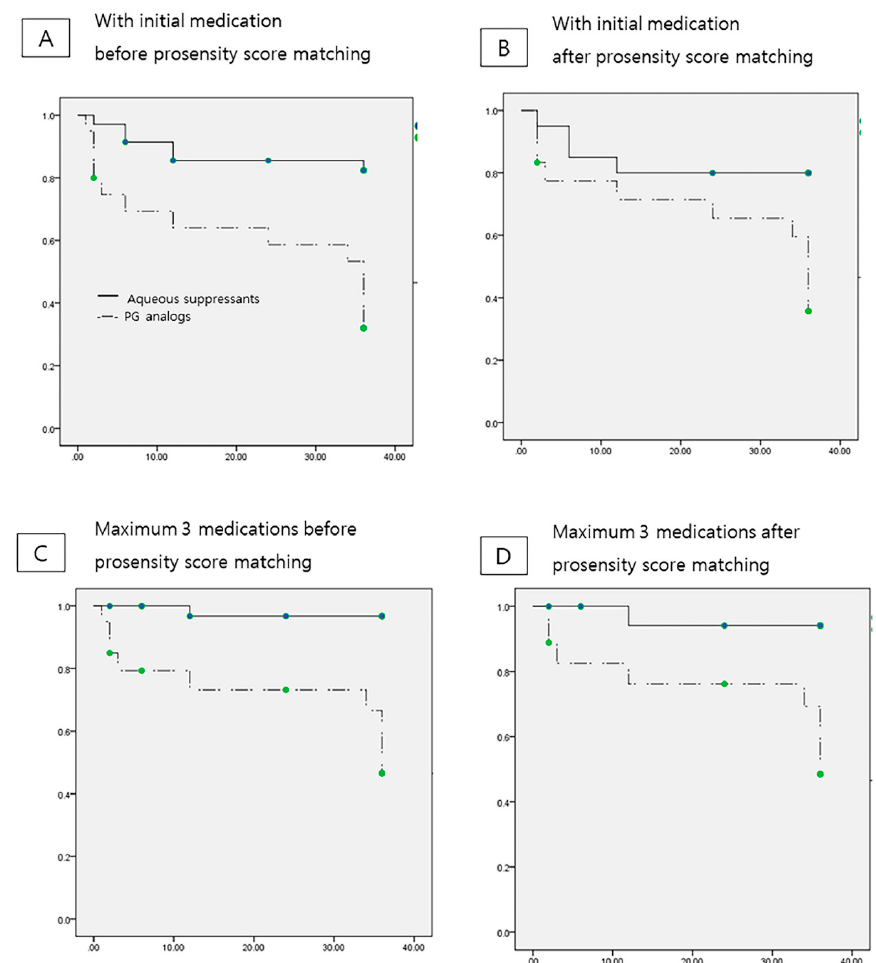
Figure 3. Kaplan–Meier analysis of the cumulative probability of qualified success over time considering initial glaucoma medication in the hypertensive phase after AGV implantation before and after propensity score matching regardless of number of medications used, the cumulative probability of qualified success was higher in the aqueous suppressants group than in the prostaglandin analogs group. With one initial medication, before propensity score matching analysis ( A ), the analysis revealed 82.9% for aqueous suppressants group, 35% for prostaglandin analog group ( p < 0.001), and after propensity score analysis ( B ), 80% for aqueous suppressants group, 38.9% for prostaglandin analog group ( p = 0.014). With maximum 3 medications, 97.1% for aqueous suppressants group, 55% for prostaglandin analog group ( p < 0.001) before propensity score matching analysis ( C ), and 90% for aqueous suppressants group, 55.6% for prostaglandin analog group after propensity score matching analysis ( D ) ( p =